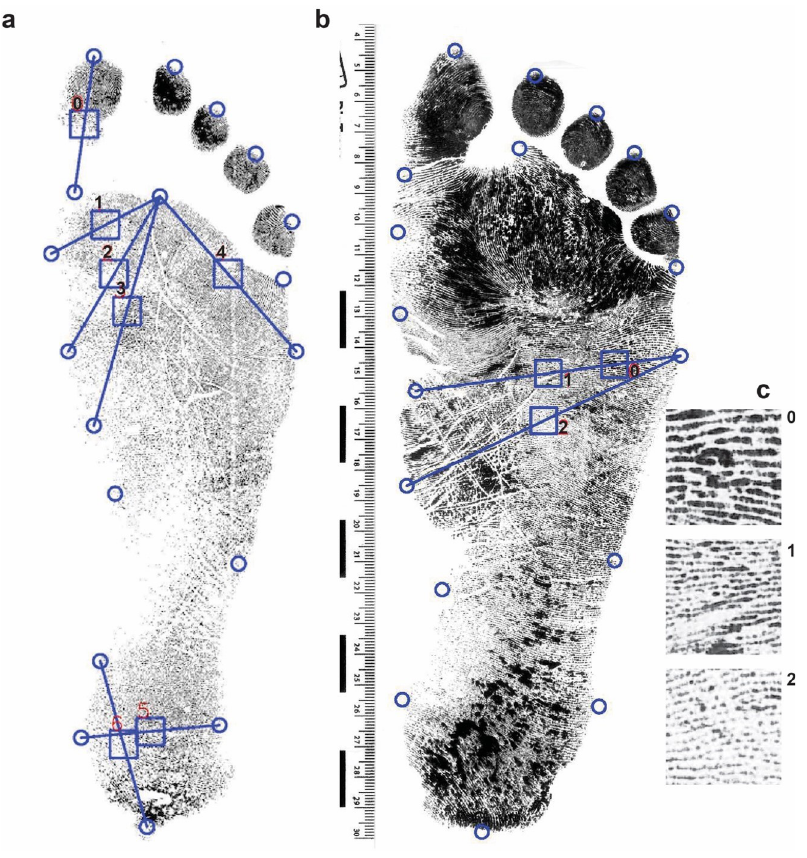
Fig 1. Landmarks and sampling areas. a. Initial sampling points mid-way between the placed landmarks. b. Revised and additional landmarks. c. Cropped sample